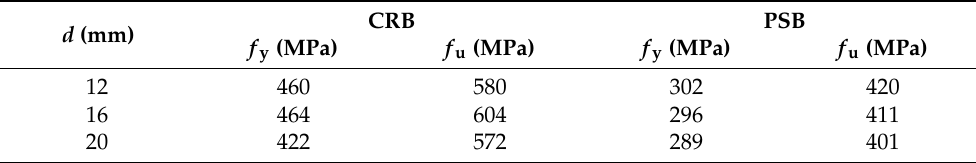
Table 4. The strength values of two kinds of steel bars.